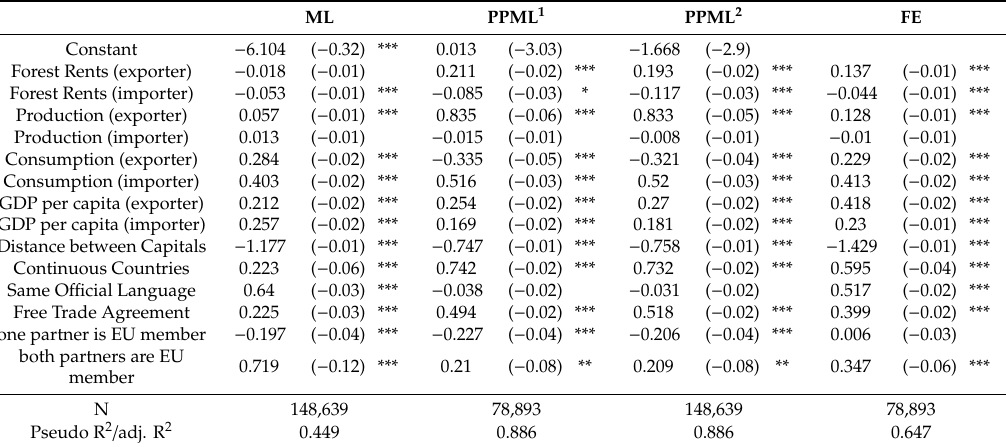
Table 2. Estimation results for the product group ‘forest